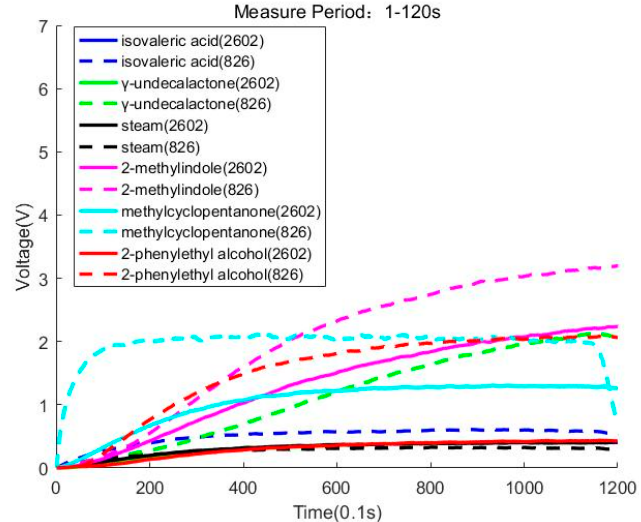
Figure 5. Sampling picture of sensors (2602, 826).